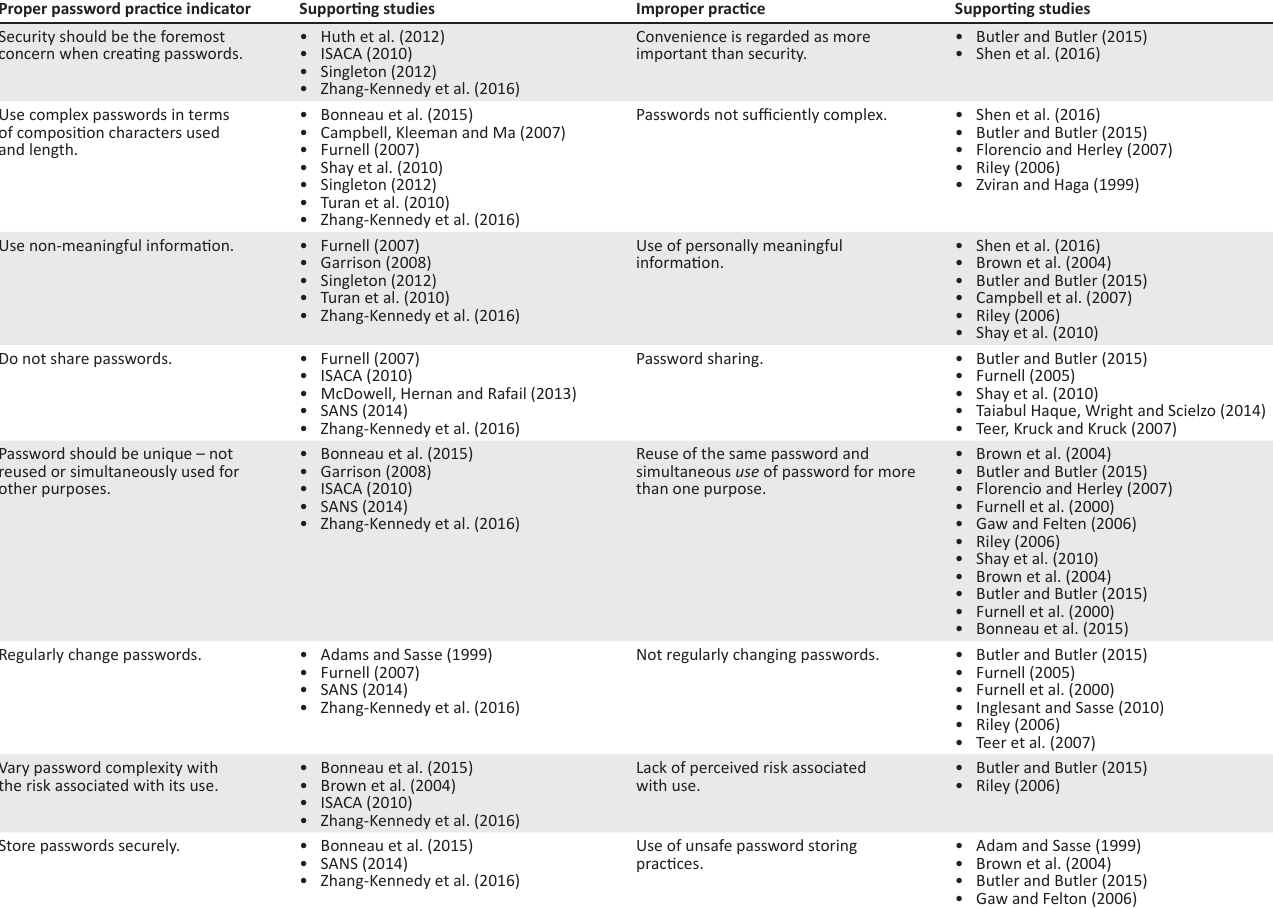
TABLE 1: Studies on common password